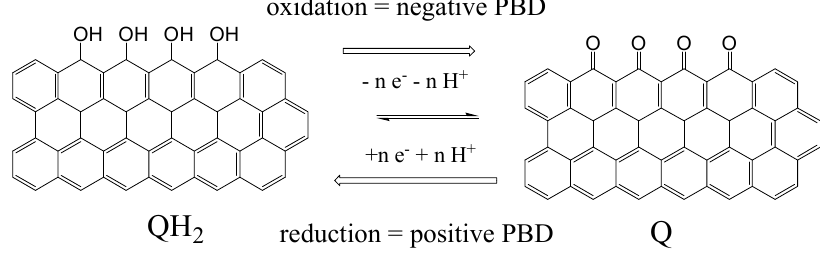
Scheme 3. Surface reactions during oxidation/reduction of a c(RF@F) electrode.